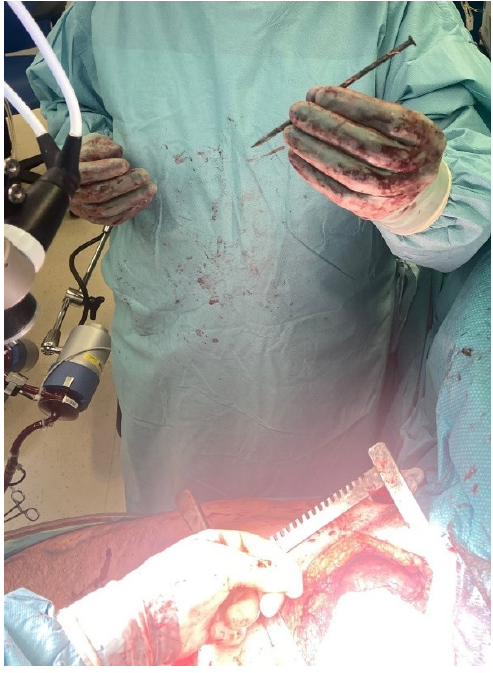
Figure 3. The 12.6 cm nail after surgical removal.